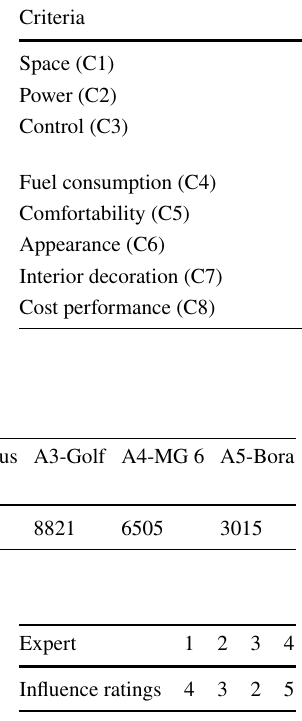
from autohome.com